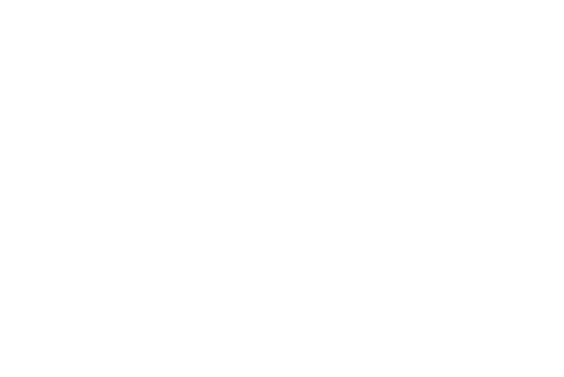
Fig. 2: Flukes of Various